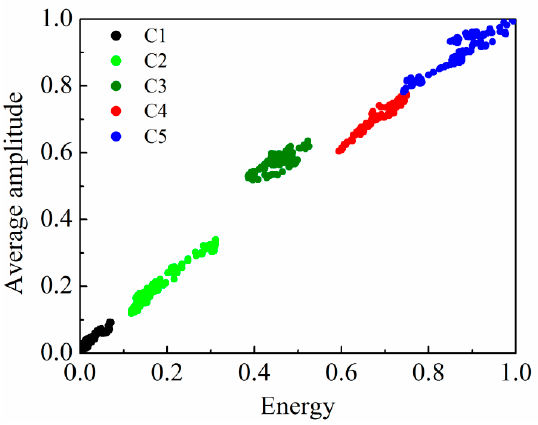
Figure 7. AP-DBSCAN results of four kinds of buried intrusion behaviors.